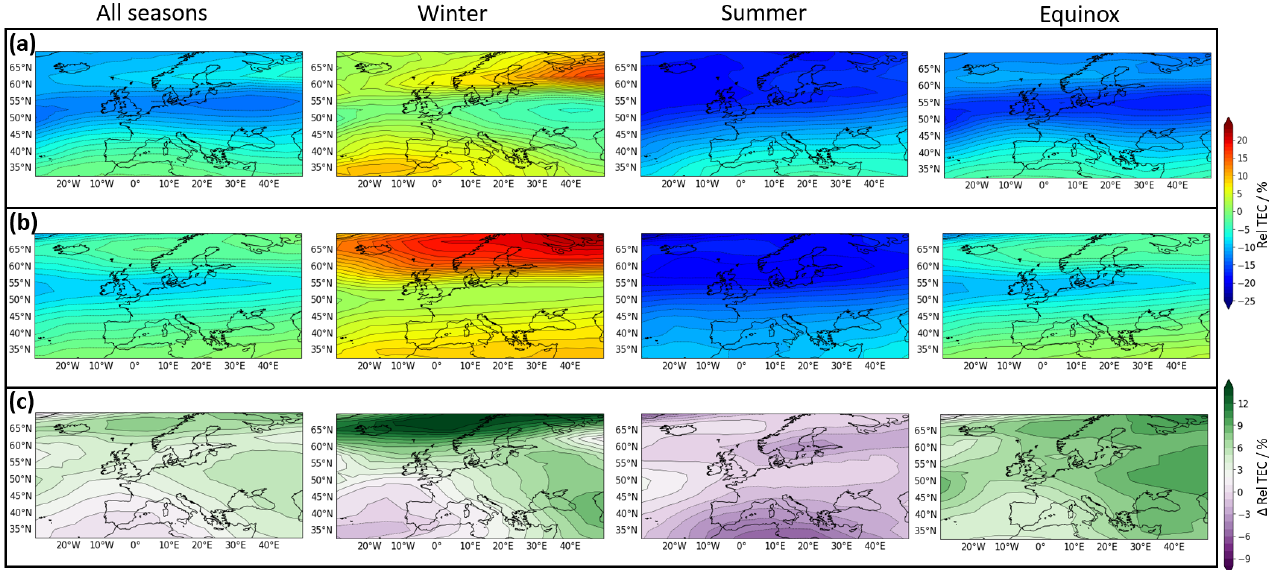
Figure 11. The relative TEC for the European region averaged for all storms in the test dataset (storms during 2015 and 2020) from the GIMs in panel ( a ), the predictions in panel ( b ) and the difference maps in ( c ). The difference maps were computed by subtracting the GIMs relative TEC from the predictions. The classification into seasons was performed according to the DOY listed in Table 1.